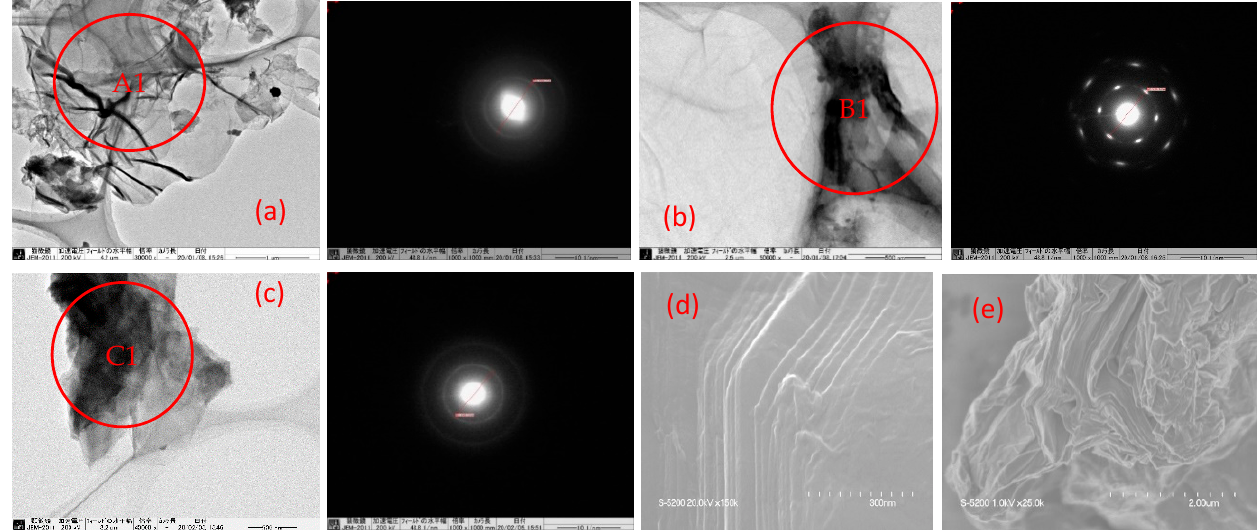
Figure 1. TEM imaging of ( a ) GO c70 , ( b ) GO c72 , and ( c ) GO c39 and SEM imaging of ( d ) GO c39 , ( e ) GO c40 , and SAED pattern from the location (A1, B1, C1) marked in pictures ( a – c ), respectively.